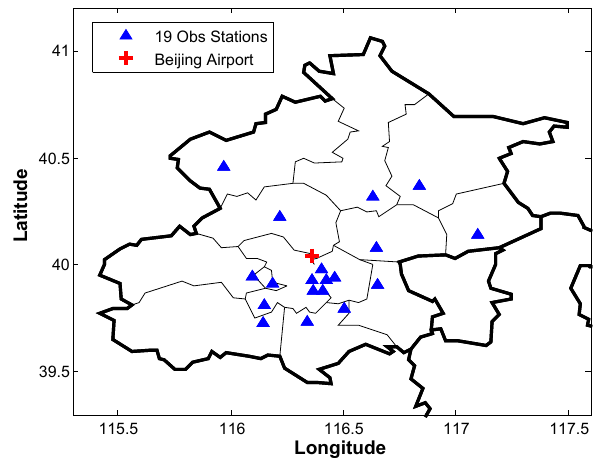
Fig. 1. Locations of the Beijing airport and 19 API observation stations in Beijing.